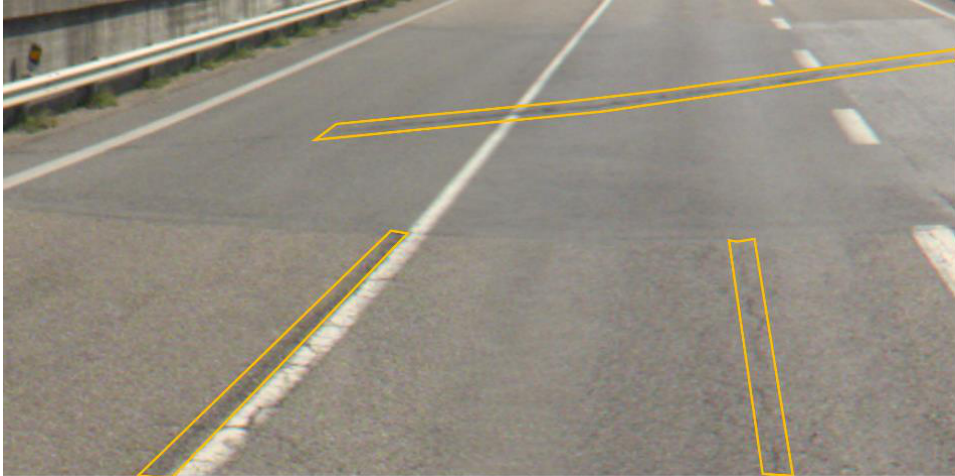
Figure 18. Road spot 4. Ladybug camera image with delimited cracked areas.